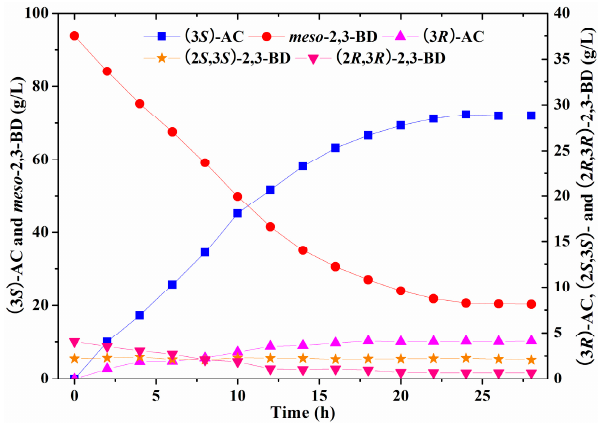
Figure 5. Time course of batch bioconversion of (3 S )-AC production from meso -2,3-BD by E. coli (pET- rrbdh - nox - vgb ) in 5-L bioreactor.